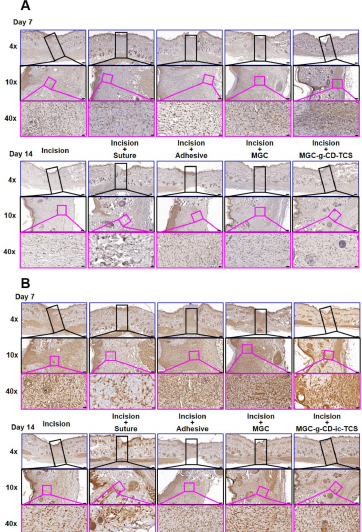
Figure 9. ( A ) Performed M1-specific anti-iNOS antibody and ( B ) M2-specific anti-mannose re- ceptor antibody immunostained images of untreated incision, and incisions treated with suture (incision + suture), cyanoacrylate (incision + adhesive), MGC (incision + MGC), and MGC-g-CD-ic- TCS (incision + MGC-g-CD-ic-TCS) after 7 and 14 days. The slides were observed at 4 × (200 µ m), 10 × (100 µ m) and 40 × (20 µ m), respectively. At 4 × images, the black rectangle boxes indicate incised part. At 10 × images, the pink rectangle boxes indicate M1-specific anti-iNOS antibody and M2-specific anti-mannose receptor antibody immunostained images.